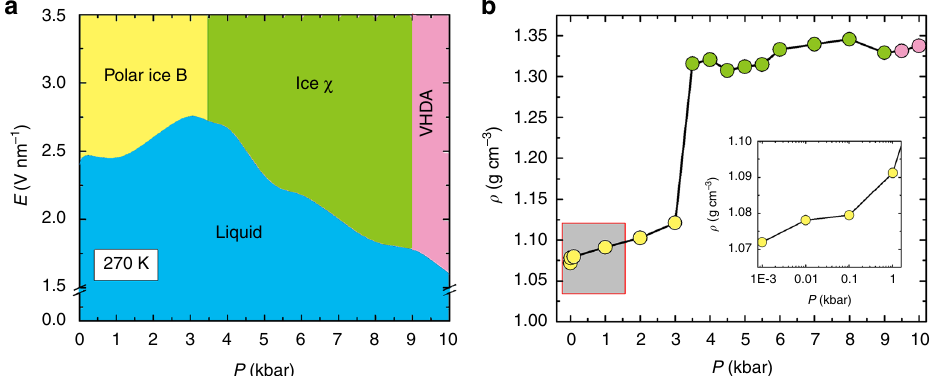
Fig. 3 P – E phase diagram and the density of ice phases. a A semi-quantitative P – E phase diagram of TIP4P/2005 water for T = 270 K. The error bar of the electric fi eld strength is 0.05 V nm − 1 . Polar ice B is denoted by the yellow region, ice χ is denoted by the green region, very-high-density amorphous (VHDA) ice is denoted by the pink region, and the liquid phase is denoted by the blue region. b The density of the ice phase vs. P (at T = 270 K and E = 3.0 V nm − 1 ). The different colour circles correspond to different ice polymorphs, denoted by the same colour in a